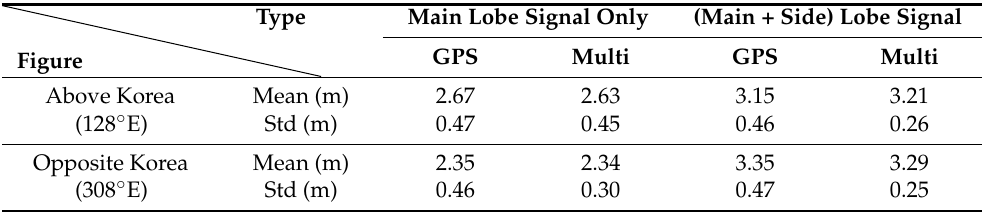
Figure 11. UERE for 24 h in Geostationary orbit. Figure 11. 𝑈𝐸𝑅𝐸 for 24 h in Geostationary orbit. Table 5. UERE for 24 h in geostationary Table 5. UERE for 24 h in geostationary orbit.